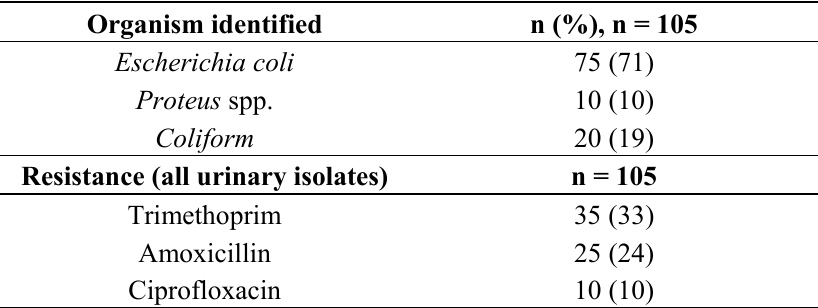
Table 2. Organisms identified in patient urine samples.